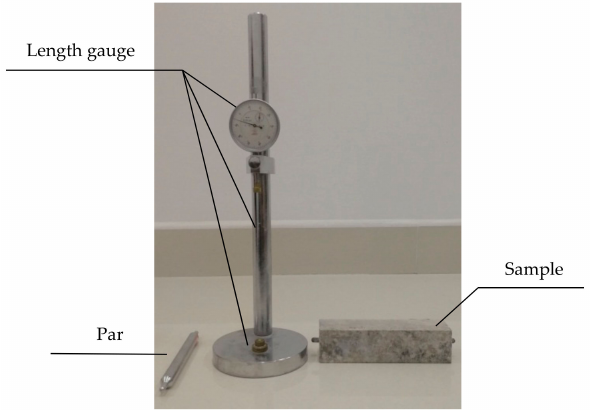
Figure 3. Length measuring instrument and test samples.